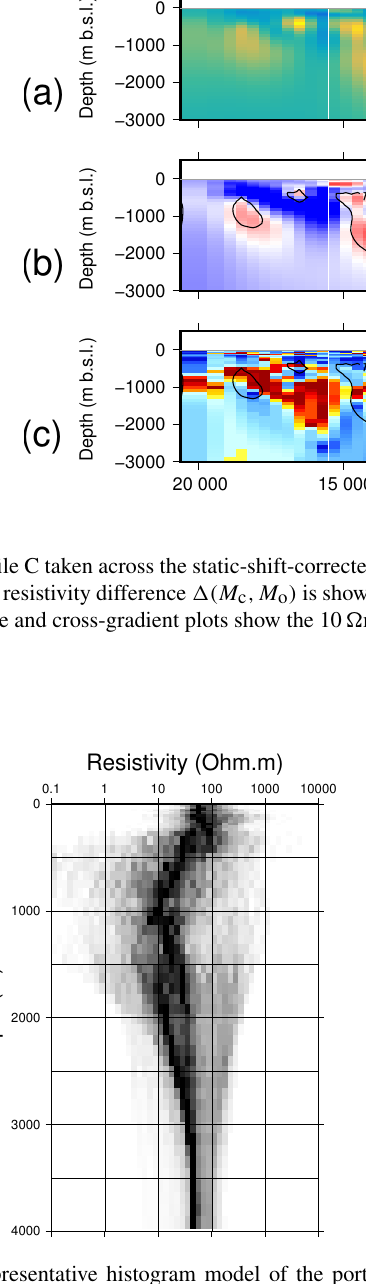
Figure 15. Representative histogram model of the portion of the static-shift-corrected model M c covering the Rathlin Basin only. Each layer represents the distribution of resistivities present in that layer of the model, normalised by the number of counts for the mode of that layer (black). Whereas a wide spread of resistivities is present from 300 to 2500m depth, the column of modal resistiv- ities can be viewed as a “typical” 1-D structure of the basin, with a distinct minimum of ≈ 10 (cid:127) m evident at 1100m depth, the depth interval of the MMG observed in the Port More 1